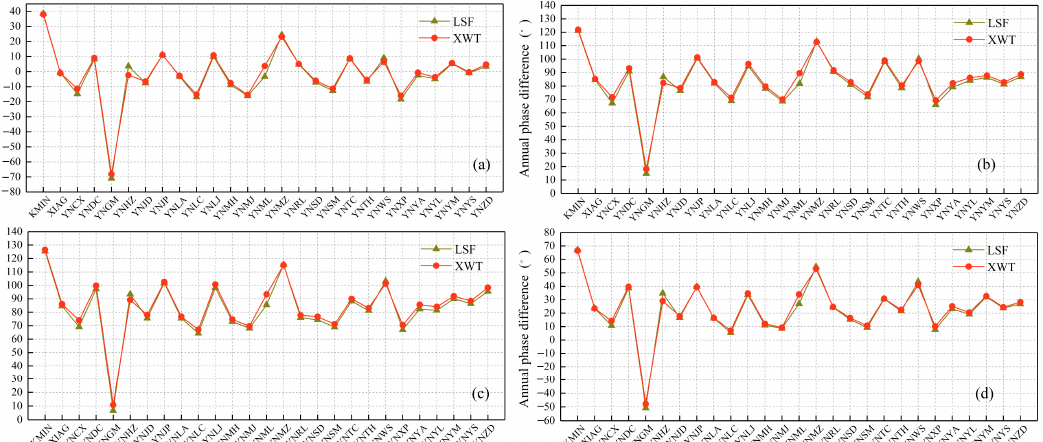
Figure 12. The difference in annual phase between the GPS and HYDL ( a ), ATML ( b ), NTOL ( c ), and their combined ( d ) time series for all stations by the LSF and XWT methods.